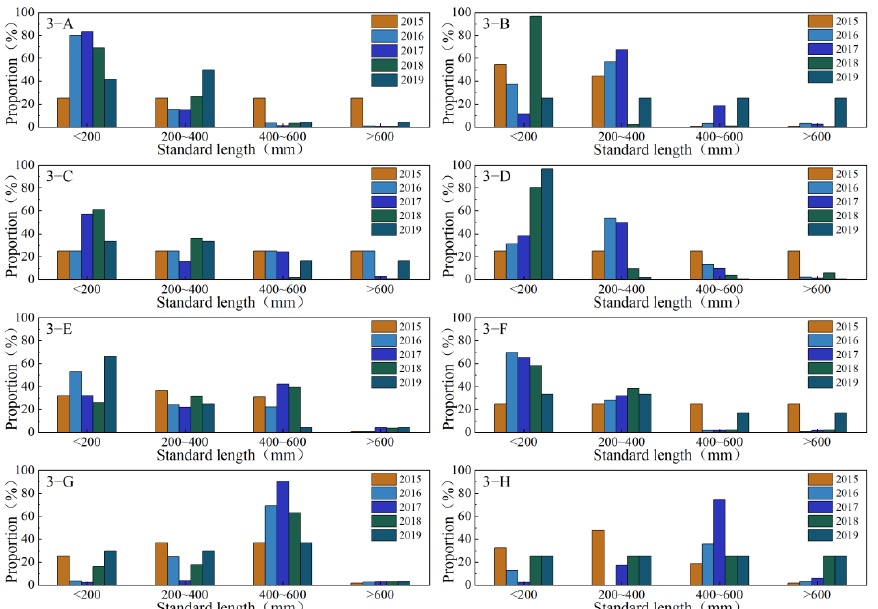
Figure 3. Section distribution characteristics of Silver Carp in the lower Yangtze River. The proportion of Silver Carp in different SL groups in AQ section ( 3 − A ), TL section ( 3 − B ), WH section ( 3 − C ), DT section ( 3 − D ), ZJ section ( 3 − E ), JJ section ( 3 − F ), CS section ( 3 − G ) and NT section ( 3 − H ).